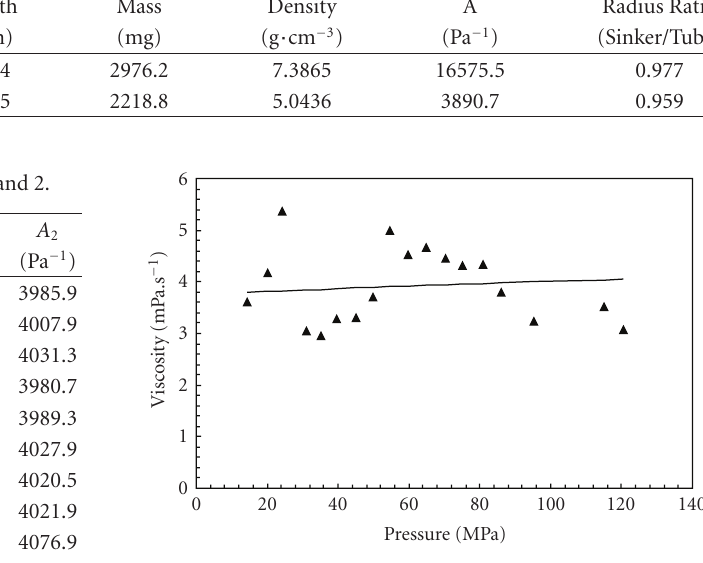
Figure 8: Viscosity Data for n-Dodecane. (cid:2) Experimental data, Caudwell et al.